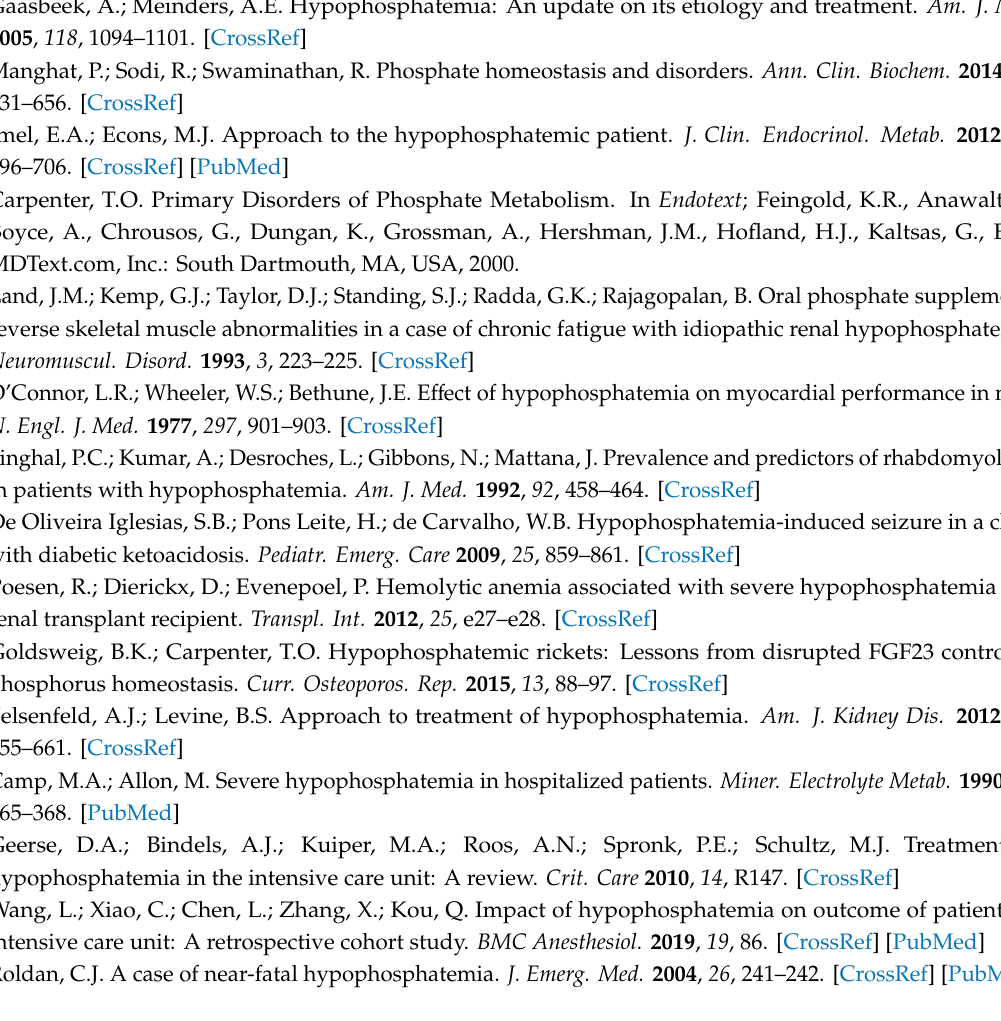
Table S1: Studies included in the pooled analysis; Table S2: Baseline characteristics of patients receiving FCM therapy; Table S3: Serious treatment-emergent adverse events possibly associated with hypophosphataemia; Figure S1: 3-step hypophosphataemia adjudication